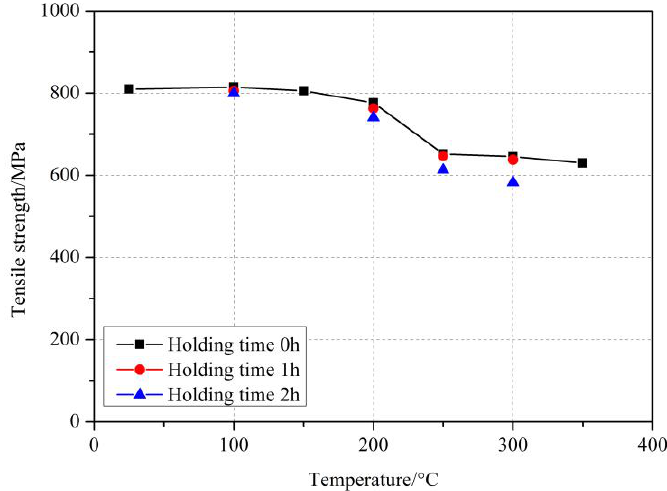
Figure 3. Tensile strength of GFRP bars after elevated temperature exposure.